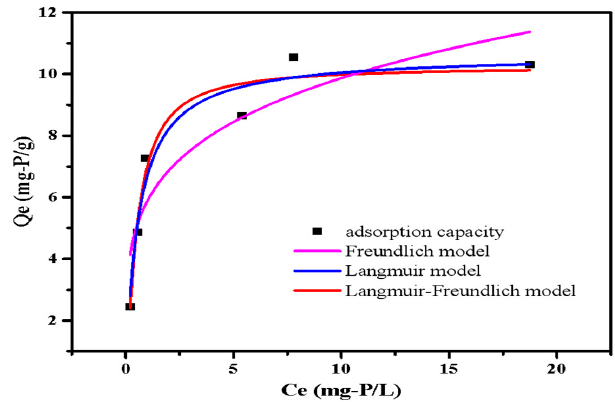
Figure 9. Isotherm models of phosphate adsorption. Table 3. Comparison of phosphate adsorption capacity.